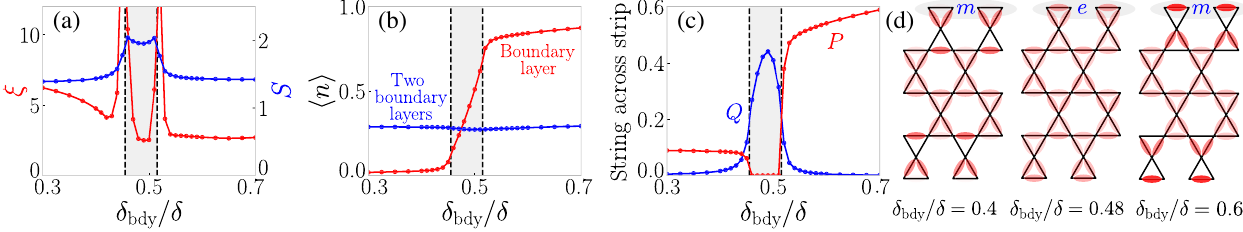
FIG. 14. Boundary phase diagram of the blockade model. We consider an infinitely long strip of the XC-8 geometry: The bulk is the spin liquid at δ = Ω ¼ 1 . 7 , but we tune δ on the outermost boundary links. (a) The correlation length diverges at two boundary phase transitions; in the intermediate shaded regime, the entanglement is increased. (b) The small and large δ phases have a classical-like bdy dimer filling at the boundary, whereas the intermediate regime has a compressible boundary. (c) By calculating the string operators from boundary to boundary, we diagnose the small and large (intermediate) δ phases as having m -condensed ( e -condensed) boundaries. bdy (d) Density plots h n i in the three boundary regimes. The strip is infinitely long (finite) in the horizontal (vertical)